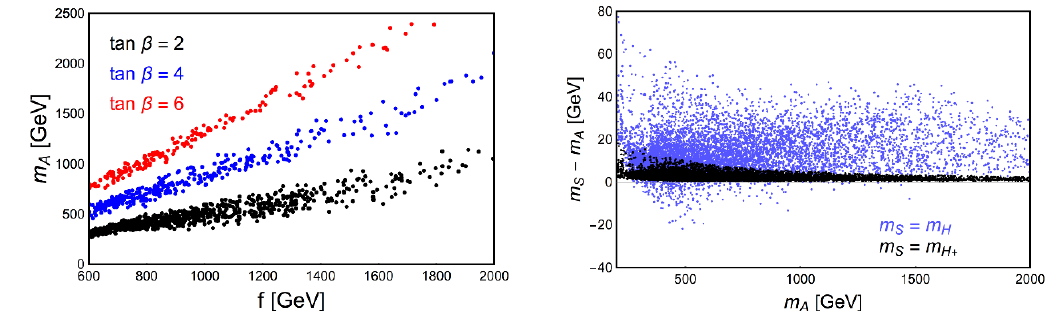
Figure 9 . (Left) The CP-odd scalar mass m A as a function of f for three values of tan (cid:12) . (Right) Mass splittings m H (cid:0) m A (blue) and m (cid:0) m A (black) versus m A H +